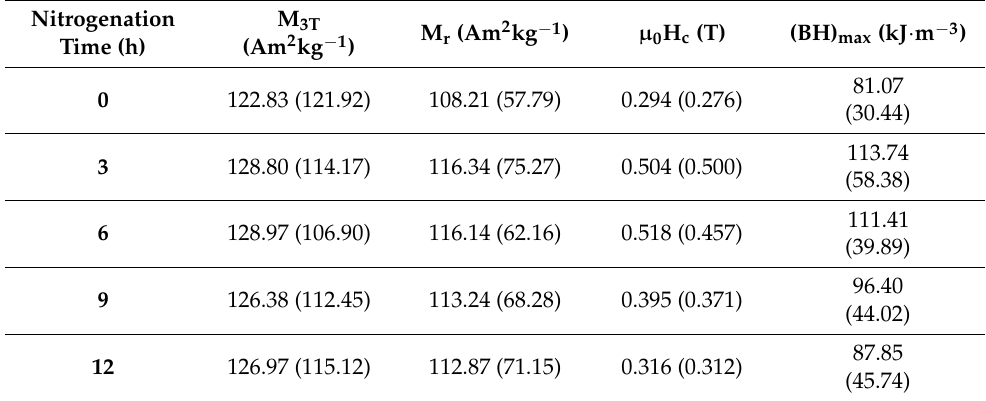
Figure 5. Hysteresis loops of the randomly oriented Nd 1.1 Fe 10 CoTiN x alloys after washing as a function of nitrogenation time. Table 2. Magnetic properties of aligned and randomly oriented (in parenthesis) Nd 1.1 Fe 10 CoTiN x powders nitrogenated for the indicated